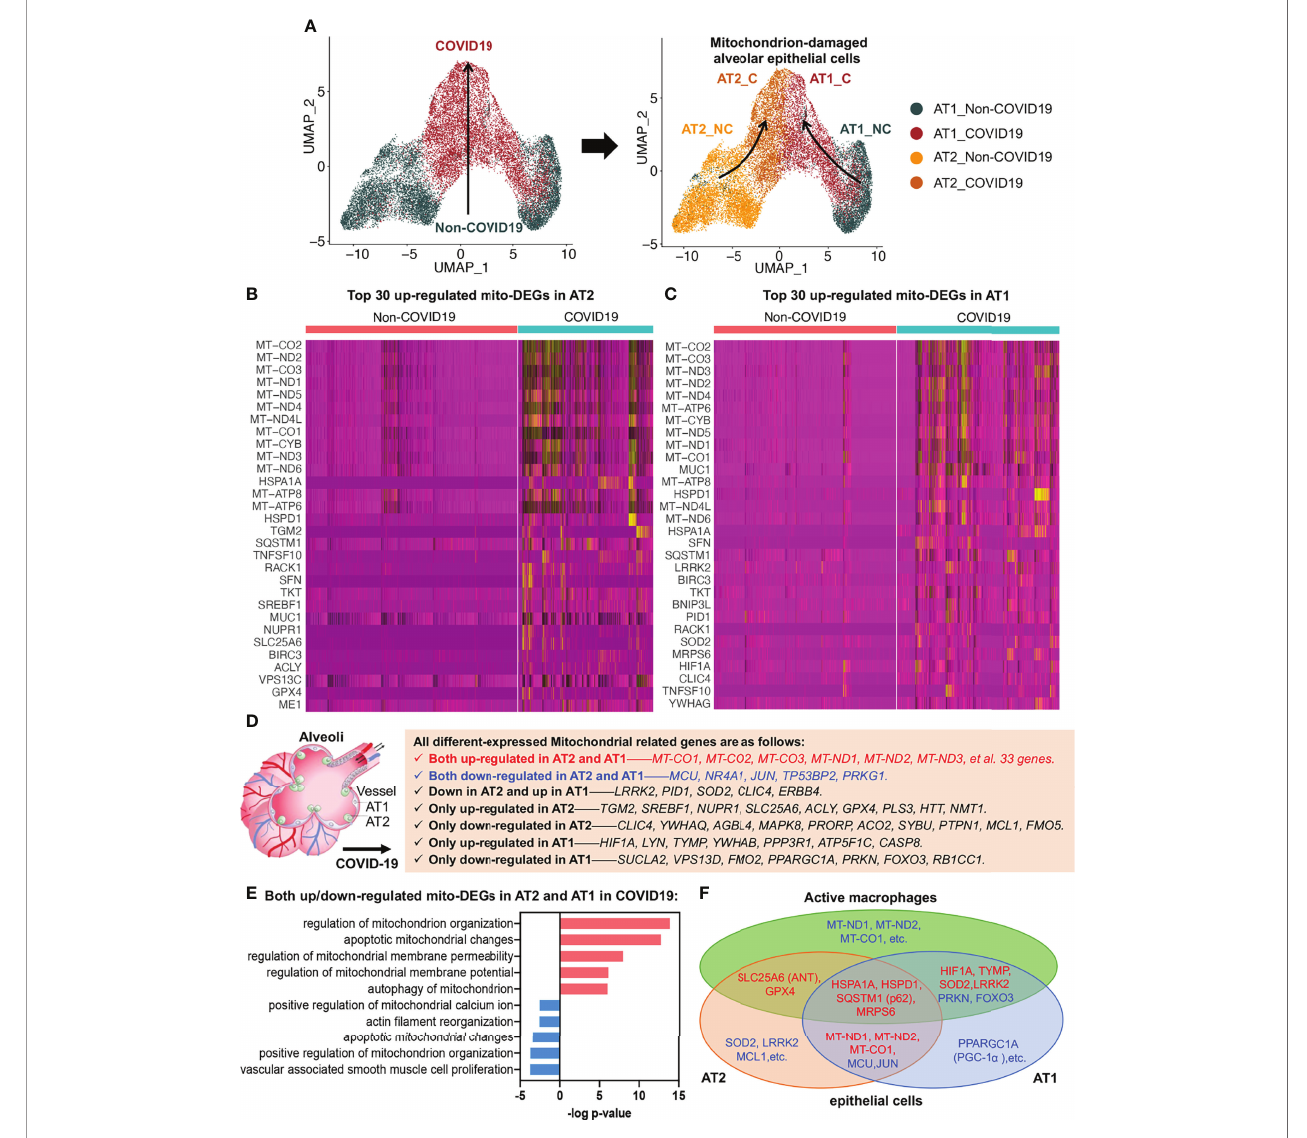
FIGURE 4 | Alveolar epithelial regeneration in COVID-19 lung tissues. (A) UMAP and corresponding group assignments of AT2 and AT1 in COVID-19. C: COVID-19 group; NC: Non-COVID-19 group. (B) Heat map of top 30 upregulated mito-DEGs in AT2 during COVID-19. (C) Heat map of top 30 upregulated mito-DEGs in AT1 during COVID-19. (D) Statistical analysis of mito-DEGs in AT2 and AT1 during COVID-19. (E) GO pathway enrichment analysis in relation to mito-DEGs in AT2 and AT1 during COVID-19. (F) Venn diagram showing the intersection mito-DEGs from AT2, AT1, and active macrophages during alveolar epithelial cells in patients with COVID-19 ( Figure S2 ).